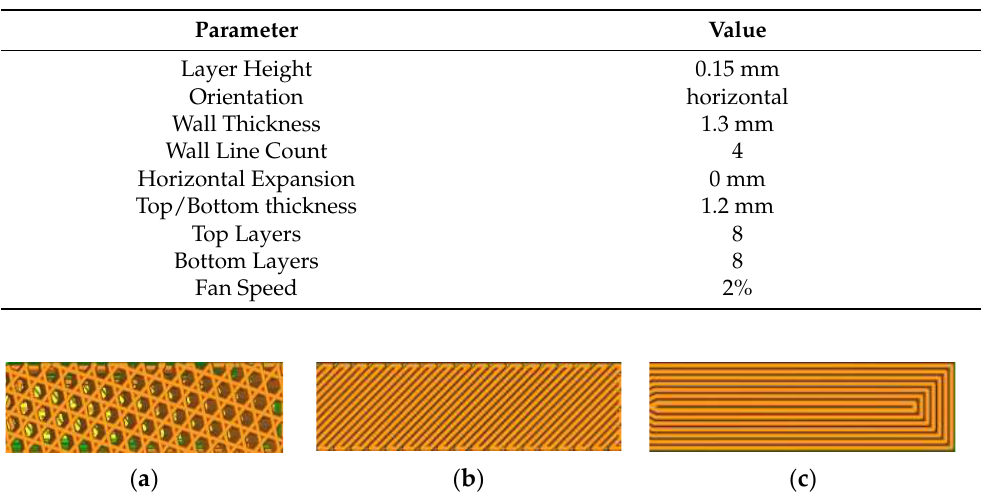
Figure 1. The profiles of internal geometries: Tri-hexagonal ( a ), Zigzag ( b ) and Concentric ( c ).